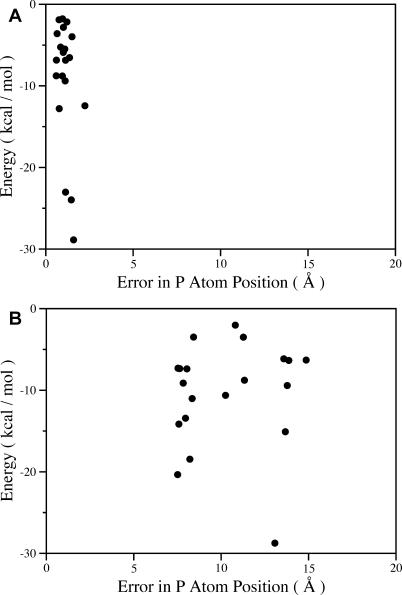
Differences in Conformational Predictions for Phosphorylated CDK2 with and without Cyclin A BoundThe 20 lowest-energy loops are considered for predicting the conformation of residues 152–163 upon in silico phosphorylation of Thr160 (A) in cyclin-bound CDK2 and (B) CDK2 in the absence of cyclin A. In (B), the x-axis represents the deviation of the phosphate from its position in the fully activated CDK2/cyclin A complex; the activation loop and pThr160 are disordered in the crystal structure of phosphorylated CDK2 in the absence of cyclin A. These calculations were performed with a consistent set of parameters that do not bias the results toward well-ordered loop structures. In the absence of cyclin A, the phosphate does not localize to the Arg cluster as in the cyclin bound case, and the 20 lowest-energy structures show considerable diversity in conformation.